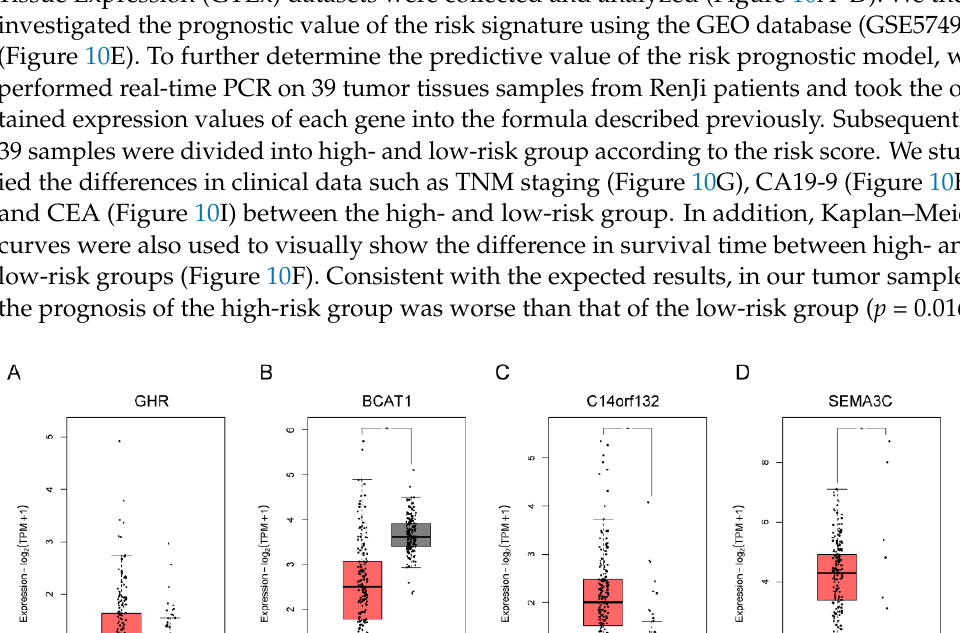
Figure 10. Verification of the Stroma- and Metastasis-Associated Risk Prognostic Model in Public Database and RenJi Samples. ( A – D ) The expression profile of the risk gene signature in TCGA and GTEx datasets ( tumor tissue was indicated in red and normal tissue in gray); ( E , F ) Survival curves regarding high- and low-risk groups in GSE57495 database and RenJi sample; ( G ) Different TNM stage counts in the high- and low-risk groups in RenJi sample; ( H , I ) Differences in tumor markers (CA19-9 and CEA) between high- and low-risk groups. * p < 0.05. 3. Discussion It is well known that the treatment of PAAD is a daunting challenge. To date, little progress has been made in the early diagnosis and effective treatment of patients with PAAD. Therefore, it is necessary to develop a new prognostic feature from the clinical and biological characteristics of PAAD, which can not only accurately predict the total survival time of patients, but also contribute to the improvement in clinical decision making. In addition, mathematical models in pancreatic cancer research suggest that PAAD does not always progress in a linear fashion but may be the result of a simultaneous increase in genetically altered cells [21]. Therefore, considering the development of prognostic strat- egies, targeting a single factor may not be sufficient to classify patients with PAAD. As one of the most malignant tumors, PAAD not only has a high mesenchymal component, but is also characterized by an extremely high metastatic risk. This study explored the